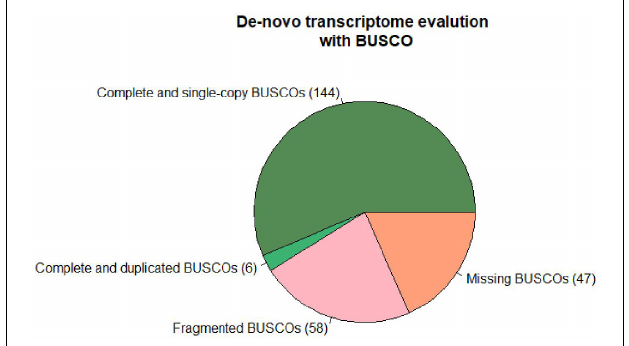
FIGURE 1 | Results of transcriptome assembly completeness calculated with